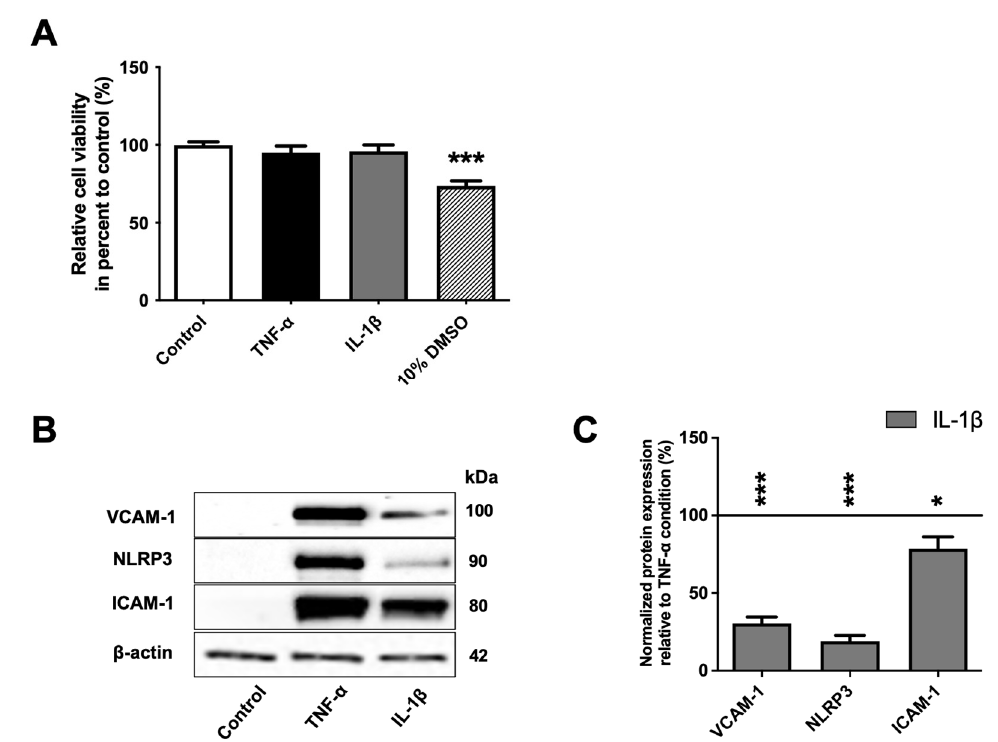
Figure 1. BLECs’ response to TNF- α and IL-1 β treatment. ( A ) After 24 h, the effects of 10 ng · mL − 1 of TNF- α or IL-1 β on cell viability were performed using MTT assay. A 10% DMSO treatment was used as positive control of cell death. ( B ) The proinflammatory markers (VCAM-1, NLRP3 and ICAM-1) after TNF- α or IL-1 β treatments were observed using Western immunoblotting. The immunoblotting images are representative of at least three independent experiments. ( C ) The protein levels of the BLEC proinflammatory markers were also quantified compared among proinflammatory treatments. The black line corresponds to the TNF- α condition value set at 100%. For A and C graphs, each bar represents the mean ± SEM and are representative of at least three independent experiments performed in triplicate. The Mann–Whitney t-test was used for the interpretation of statistical data with a threshold of statistical significance compared to the control condition or among proinflammatory cytokines set at * p < 0.05 or *** p < 0.001. VCAM-1: vascular cell adhesion protein-1; NLRP3: « NOD-like receptor family, pyrin domain containing 3; ICAM-1: intercellular adhesion molecule-1.